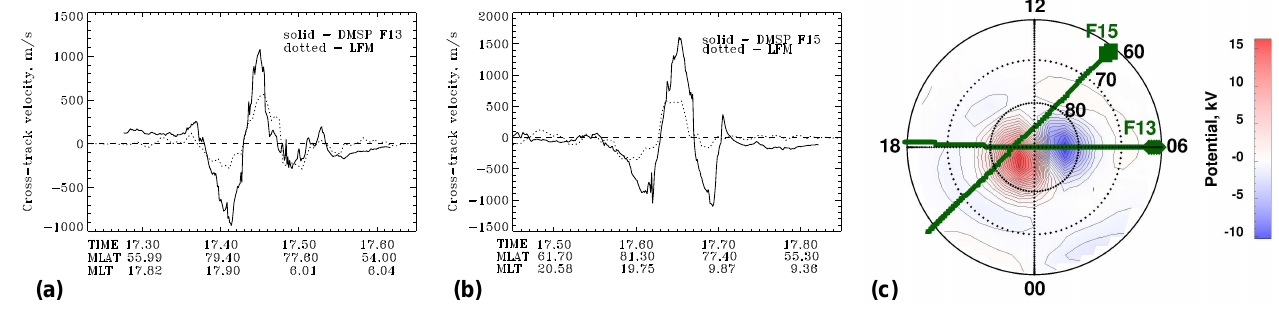
Fig. 4. Comparison of the cross-track drift velocity measured by DMSP F13 (a) and F15 (b) satellites with double resolution LFM simulations for the polar passes during 17:14–17:40 UT and 17:26–17:53 UT, respectively. The polar plot (c) shows the LFM-simulated Northern Hemisphere electrostatic potential pattern, averaged from 17:00 UT to 18:00 UT, with the satellite trajectories overplotted.